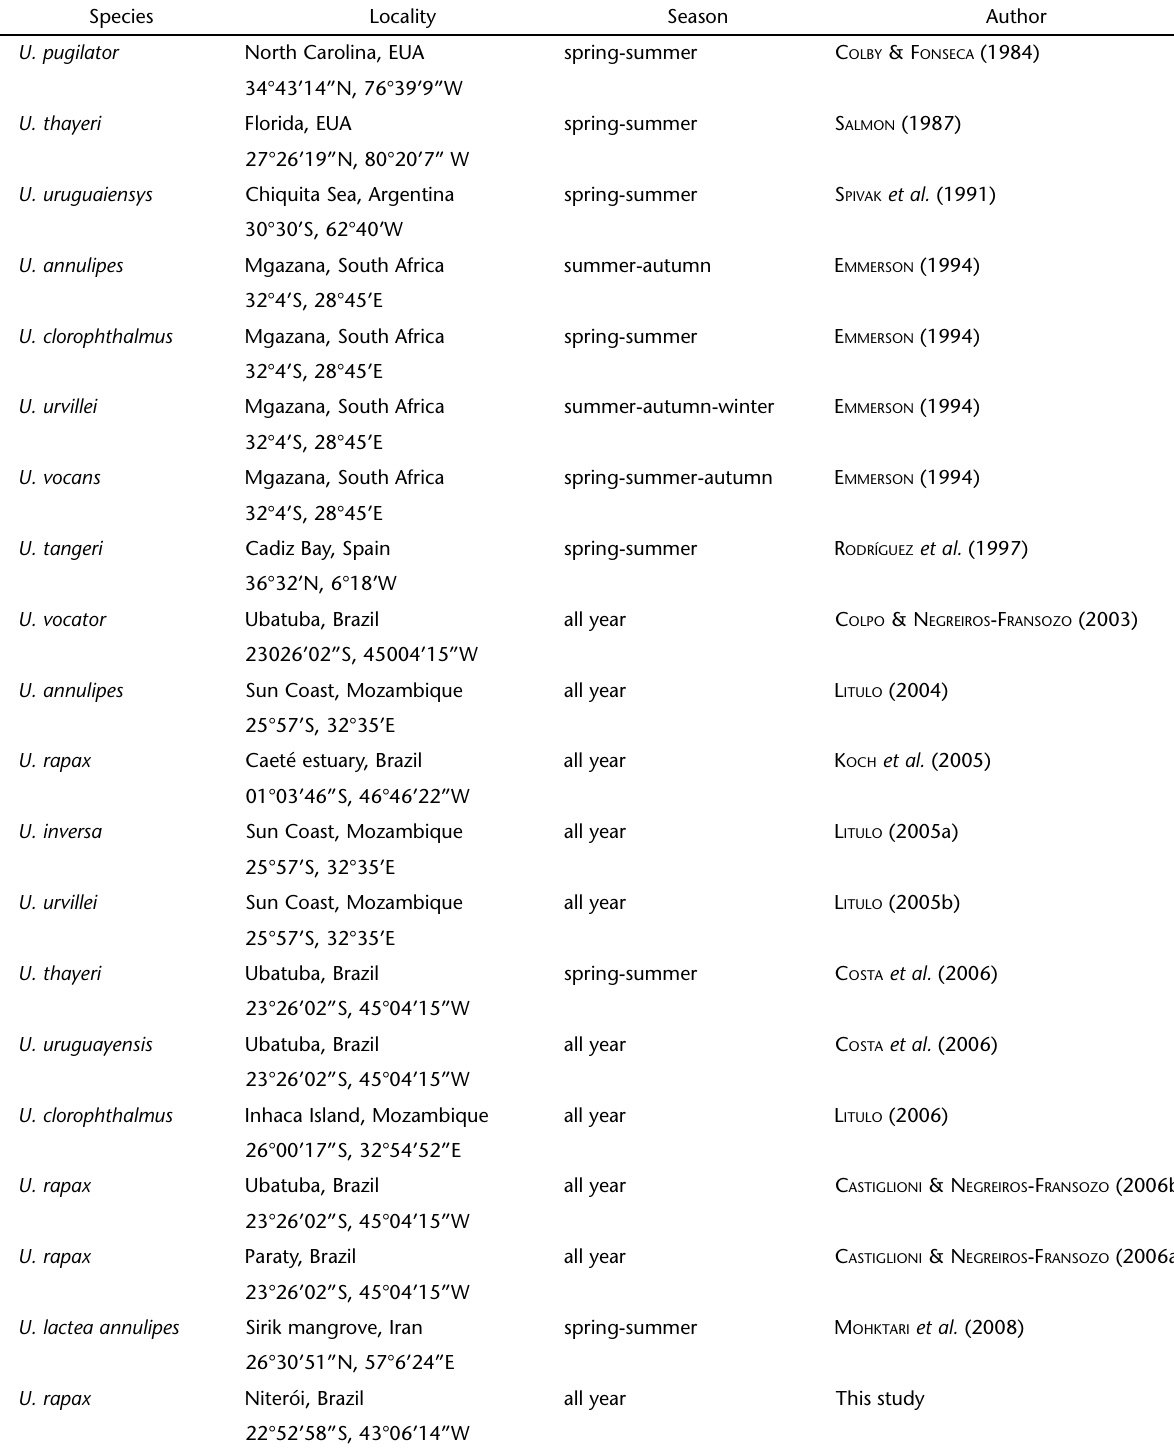
Table IV. Reproductive period of fiddler-crab species from different